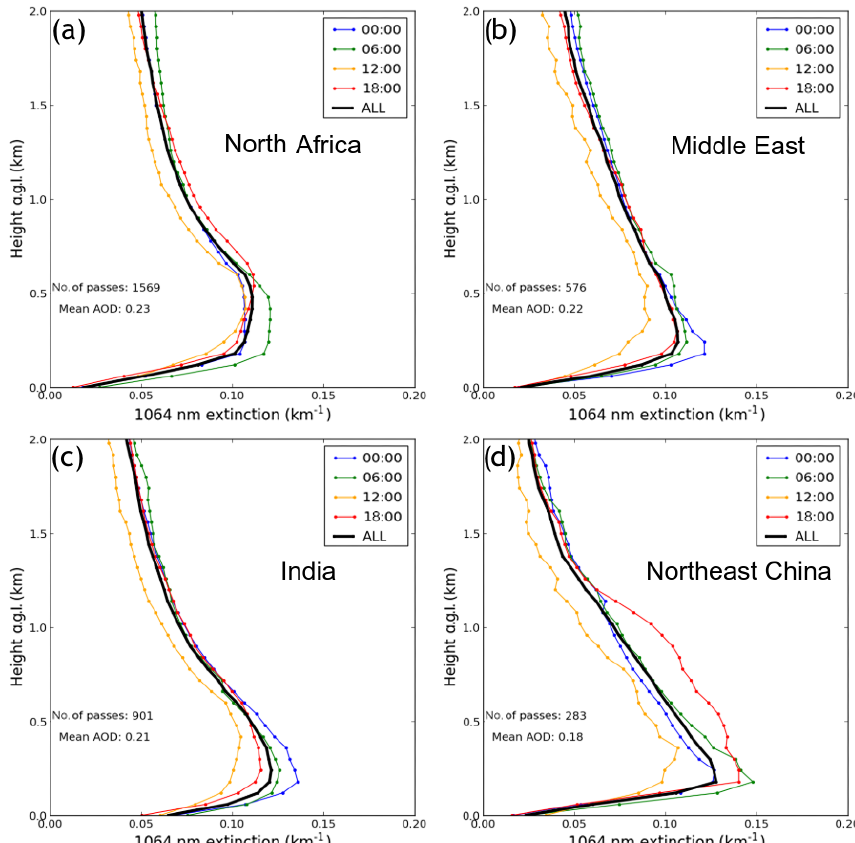
Figure 12. DJFMAM 6h average (00:00, 06:00, 12:00 and 18:00LT) vertical profiles of CATS 1064nm for locations shown in Fig. 6a; (a) north Africa, (b) the Middle East, (c) India and (d) northeast